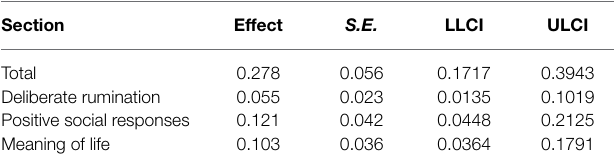
TABLE 3 | Indirect effect of deliberate rumination, positive social responses, and meaning of life.